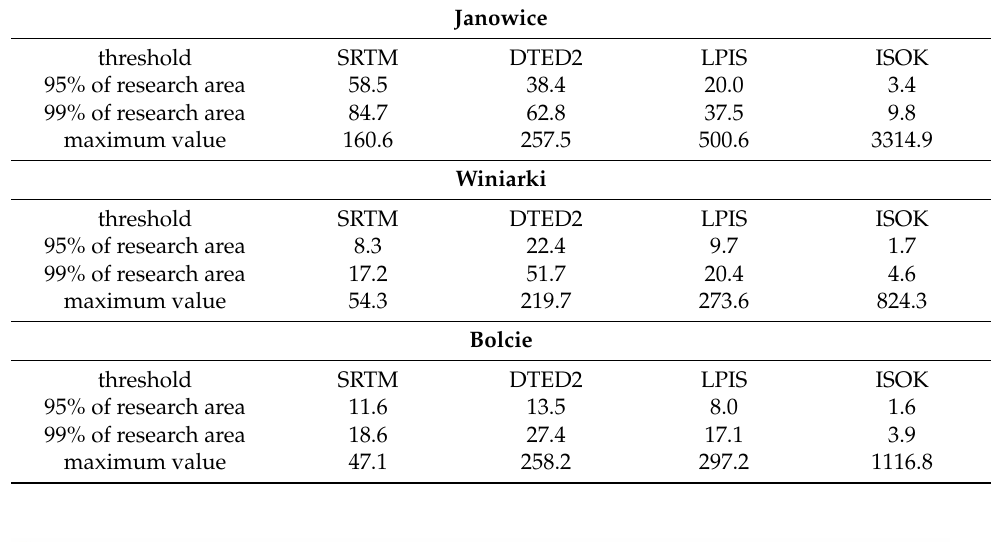
Table 11. Comparison of the maximum of the total LS factor threshold values for 95% and 99% of the area in the 3 research areas.